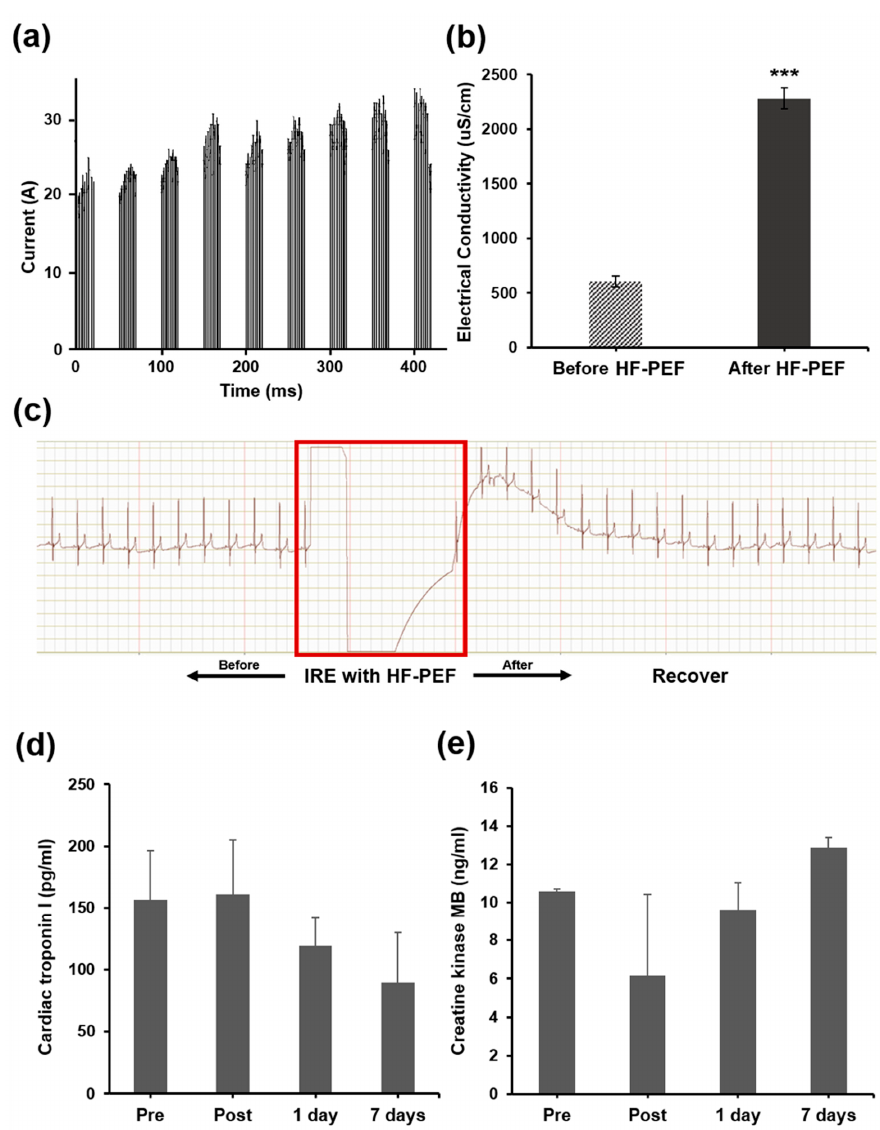
Figure 3. Current, electrical conductivity changes of the prostate tissue, cardiac safety, and biochem- istry of the beagles after irreversible electroporation (IRE) with high-frequency pulsed electric field (HF-PEF). ( a ) Current of 9 groups of 10 pulses/group (interval times between pulses in the same group were omitted for being comparably long [~10 s]). ( b ) The electrical conductivity of prostate. Average treatment time was 420 ± 190 s. *** p < 0.001, compared with before IRE with HF-PEF. ( c ) Electrocardiogram of the beagle before and after IRE with HF-PEF (red box). Changes in ( d ) cardia troponin I and ( e ) creatine kinase MB levels.